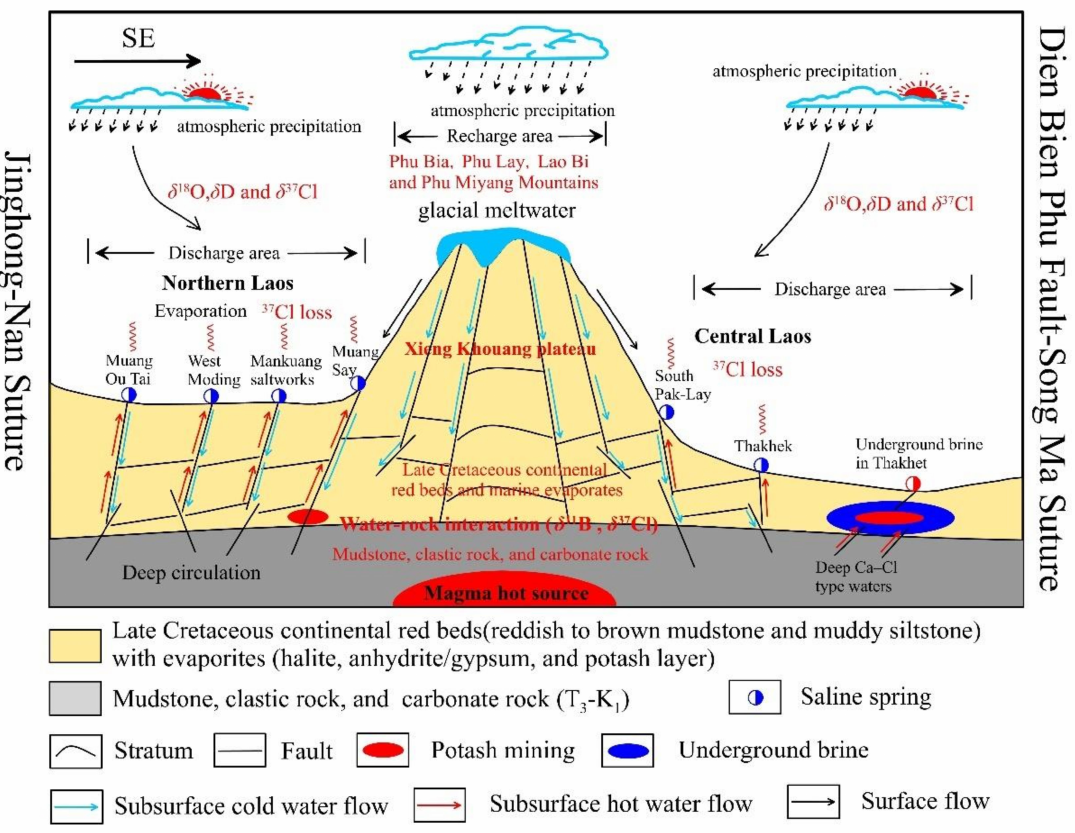
Figure 12. Conceptual model of saline springs based on hydrochemistry, δ D, δ 18 O, δ 11 B, and δ 37